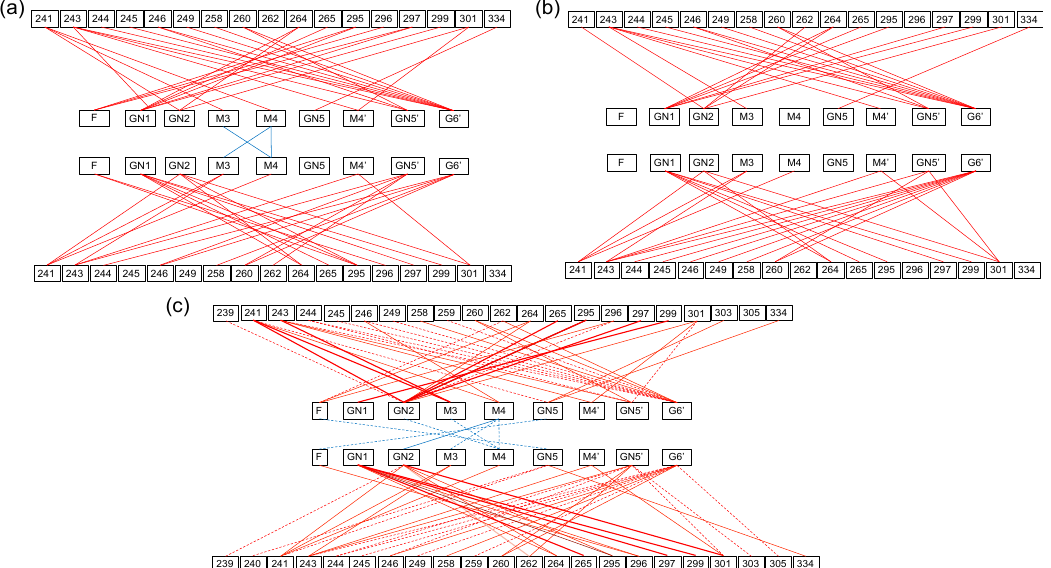
Figure 4. Intramolecular interaction networks of the IgG1-Fc glycans. A pair of contact residues between the N-glycan and the polypeptide chain or between the two N-glycans found within 4 Å is connected by a line segment for the crystal structures of ( a ) Fc alone (3AVE) and ( b ) sFcγRIIIa-bound Fc (5XJE). The terminal galactose residues of α1-6Man branch in 3AVE were modeled as described in the Materials and Methods. The contact pairs involving either of these galactose residues are conserved in the crystal structure 5IW3, which gave electron densities of the terminal galactose residues. ( c ) Pairs of contact residues found within 4 Å in the ensemble model derived from the MD simulation are connected by different types of line segments (red for carbohydrate-protein contact and cyan for carbohydrate-carbohydrate contact) according to incidence as follows: More than 24,000 pairs (thick solid line), 24,000 to 16,000 pairs (thin solid line), and 16,000 to 8,000 pairs (dashed line).